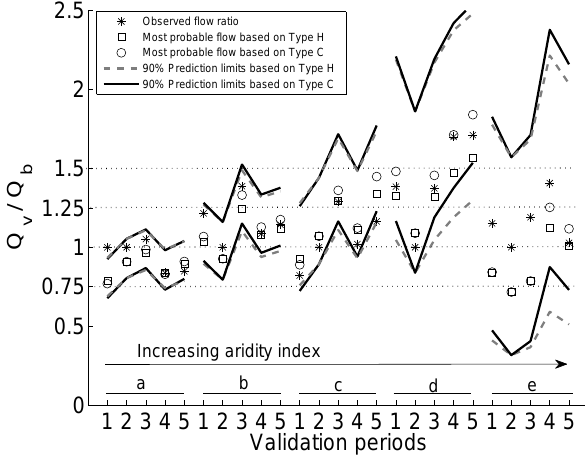
Fig. 3. Validation plot showing the ratio of validation period stream- flow (Q v ) to base period streamflow (Q b ) for the 5 study watersheds sorted by increasing aridity index (PE/ P ) ( (a) Lochsa, (b) Lower Androscoggin, (c) Escambia, (d) Meramec, (e) Yampa). Validation periods are 1: 1948–1958, 2: 1958–1968 (base period), 3: 1968– 1978, 4: 1978–1988, 5: 1988–1996. Dashed and continuous lines show the 90% prediction limits for historical conditioning and con- ditioning based on changing climate